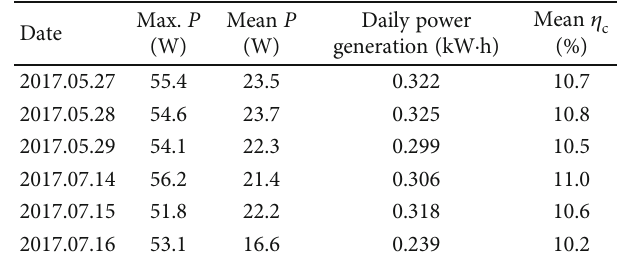
Table 5: Photovoltaic